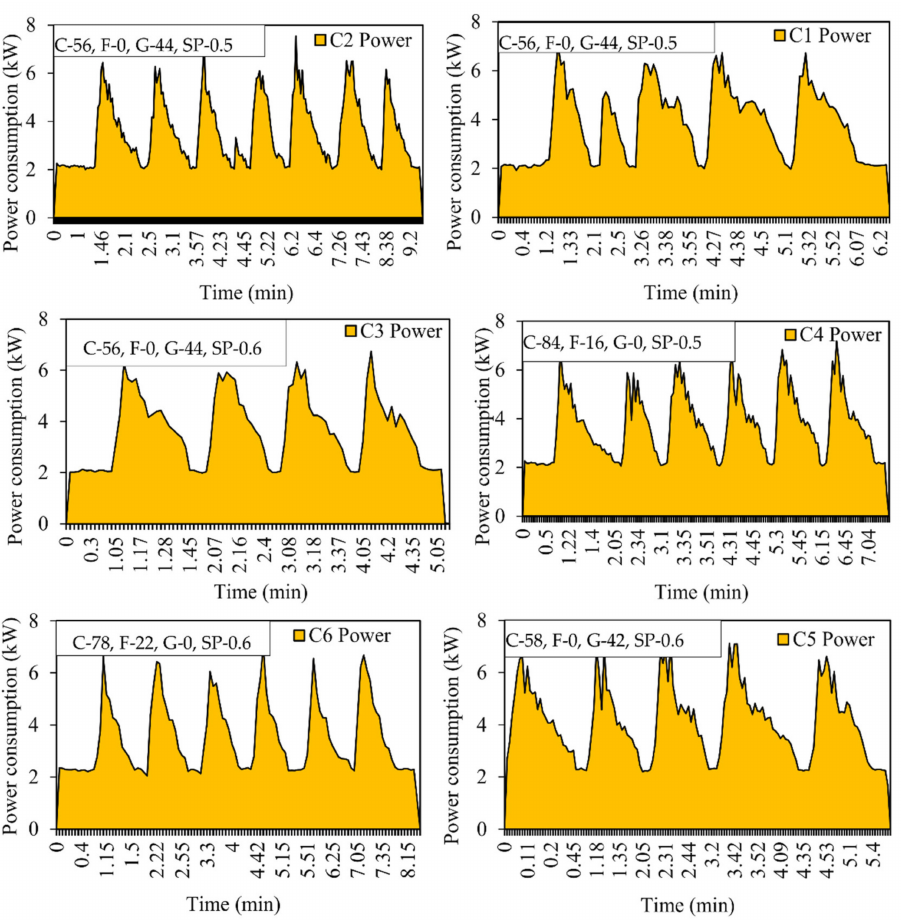
Figure 7. Energy consumption curve for M40 grade concrete for Mix C1, C2, C3, C4, C5, and C6. C—Cement, F—Fly ash, G—GGBS, SP—Superplasticizer (expressed in